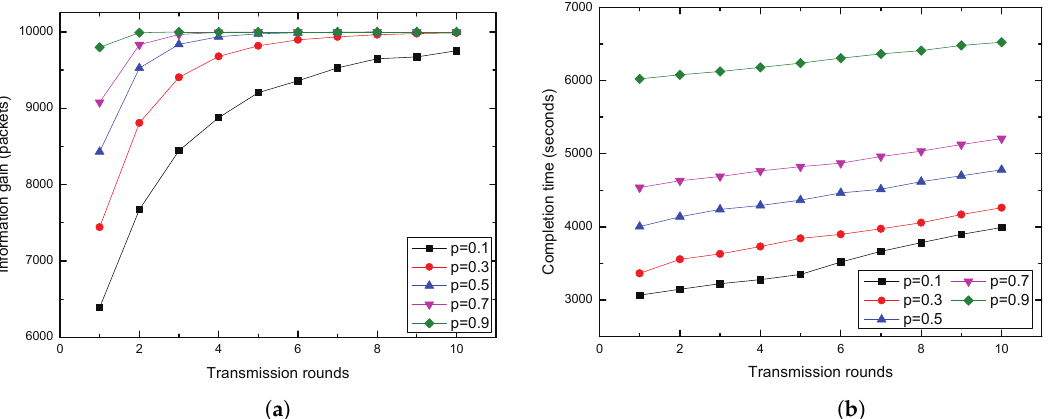
Figure 10. ( a ) Average information gain VS transmission rounds; ( b ) Average completion time VS transmission